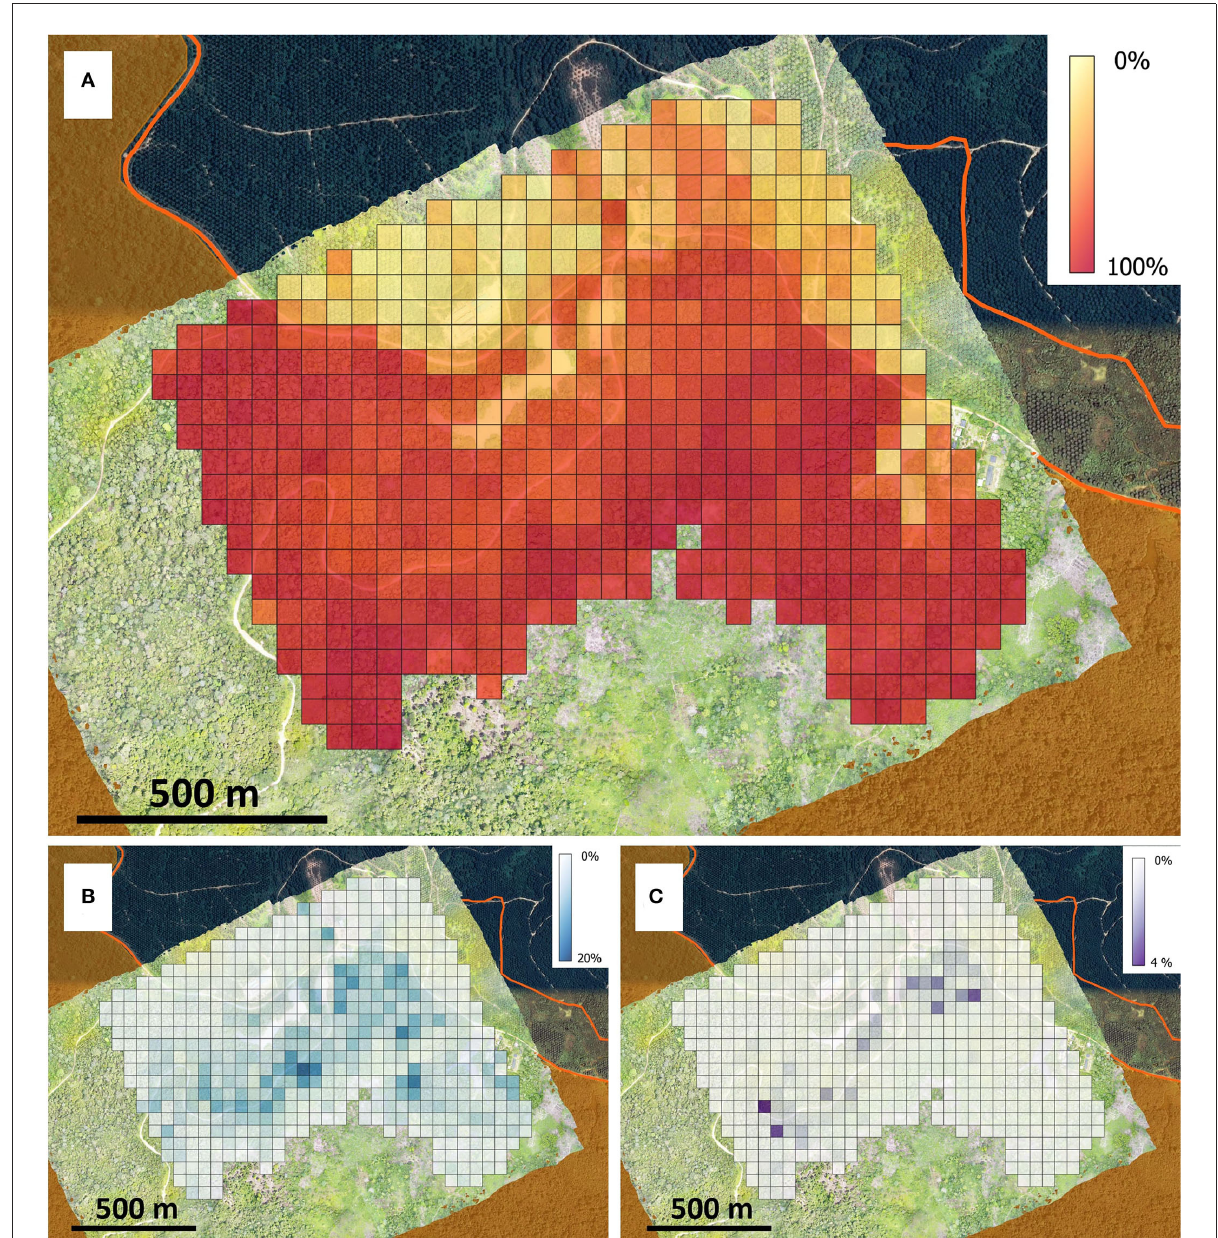
FIGURE9 Map of the percentage occurrence by area of vegetation species in 0.25 ha cells across the study area as predicted by the superpixel SVM model including all species. (A) Shows the combined occurrence for long-lived species for Alstonia scholaris , Endospermum malaccense and “other” tree species, with (B) showing Bellucia pentamera alone, and (C) showing Macaranga gigantea